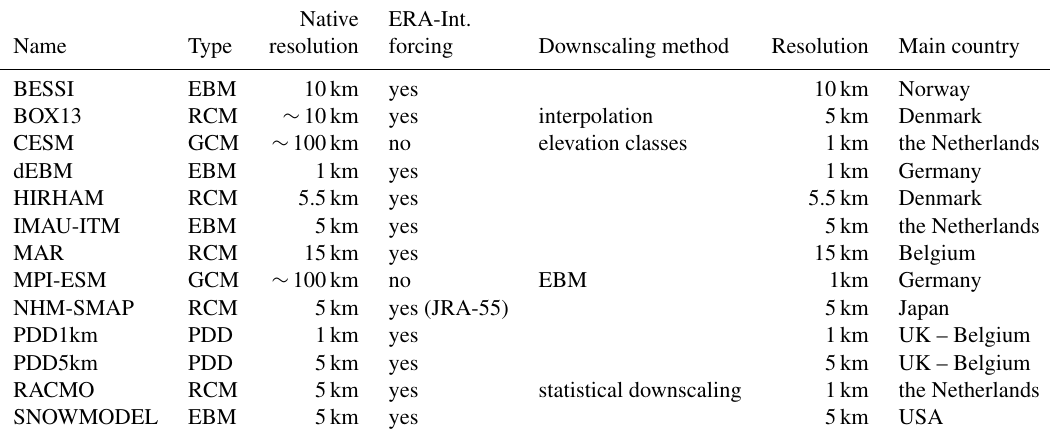
Table 1. List of the 13 models used in this study listing the type (energy balance model (EBM), regional climate model (RCM), general circulation model (GCM), positive degree day (PDD) model), the forcing (the ERA-Interim or JRA-55 reanalysis), the native resolution, the method eventually used afterwards to downscale the surface mass balance (SMB) at 1km (when it is different than the one use to interpolate all the outputs to 1km; see Sect. 2.2) and the country where the main development takes place.